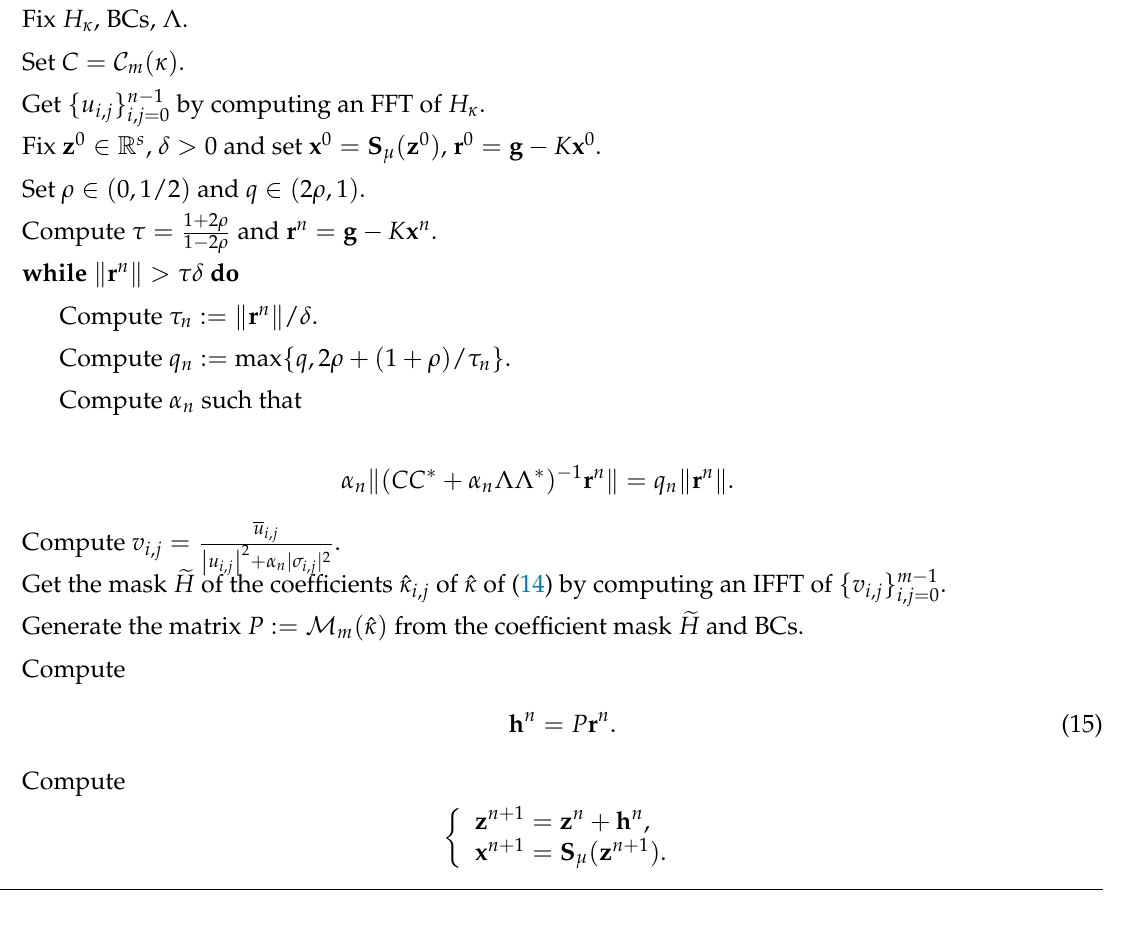
Algorithm 3 Struct-PISTA